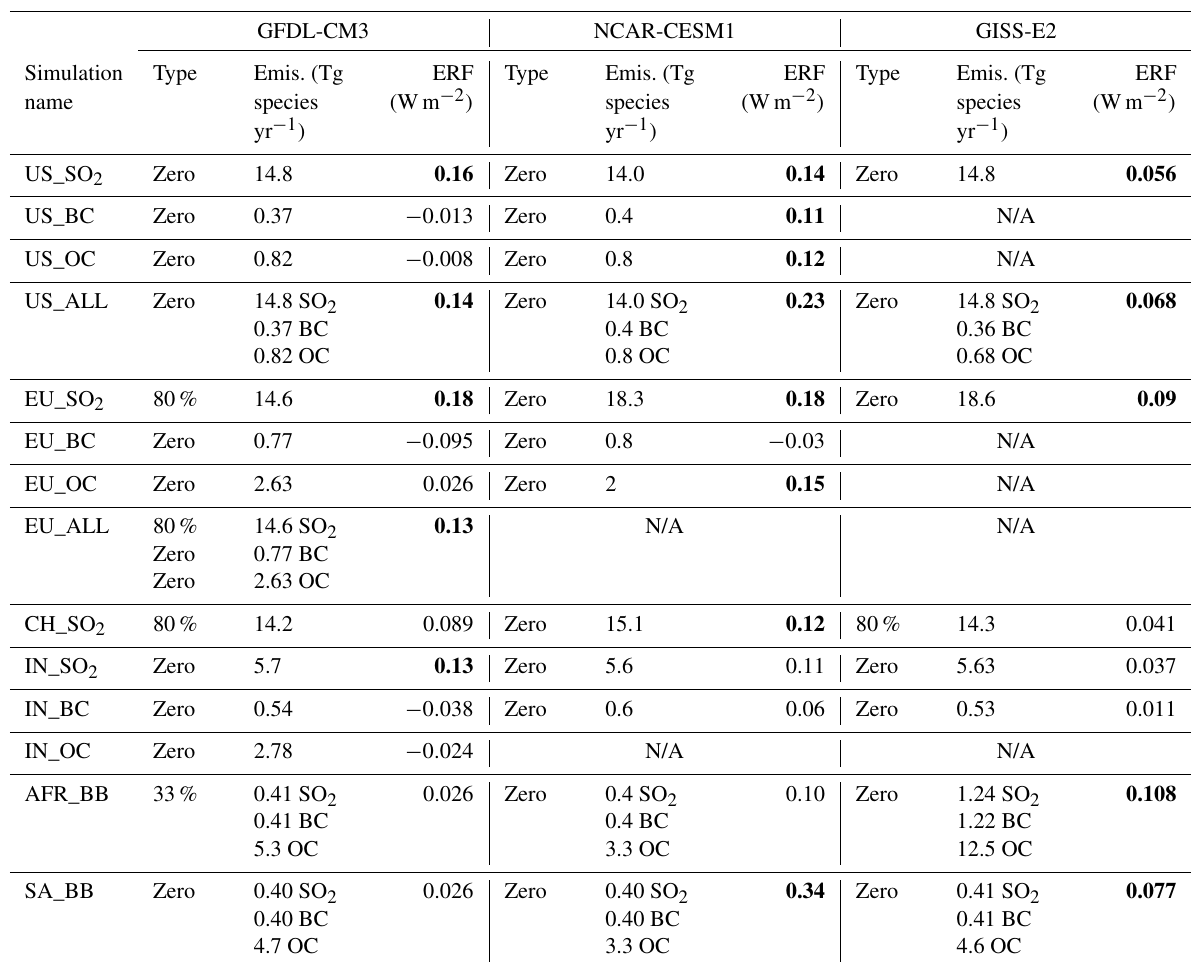
Table 1. List of aerosol perturbation simulations, emissions reductions relative to the control simulation, and corresponding aerosol effective radiative forcing (ERF). SO 2 : sulfur dioxide, BC: black carbon, OC: organic carbon aerosol, ALL: SO 2 + BC + OC, BB: biomass burning, US: United States, EU: Europe, CH: China, IN: India, AFR: Africa, SA: South America. N/A means that the particular simulation was not performed with this model. “Zero” refers to a zero-out of emissions, and 80% refers to an 80% reduction. Boldface values reported in Table 1 indicate statistical significance at the 2 σ (95%)